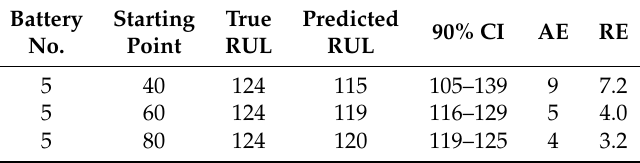
Table 2. RUL prediction for battery No. 5 under different starting points.